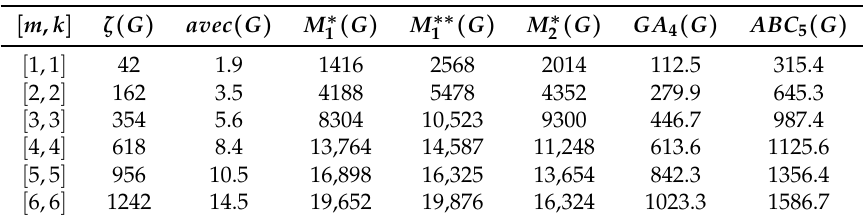
Table 3. Numerical computation of all indices for OX n .